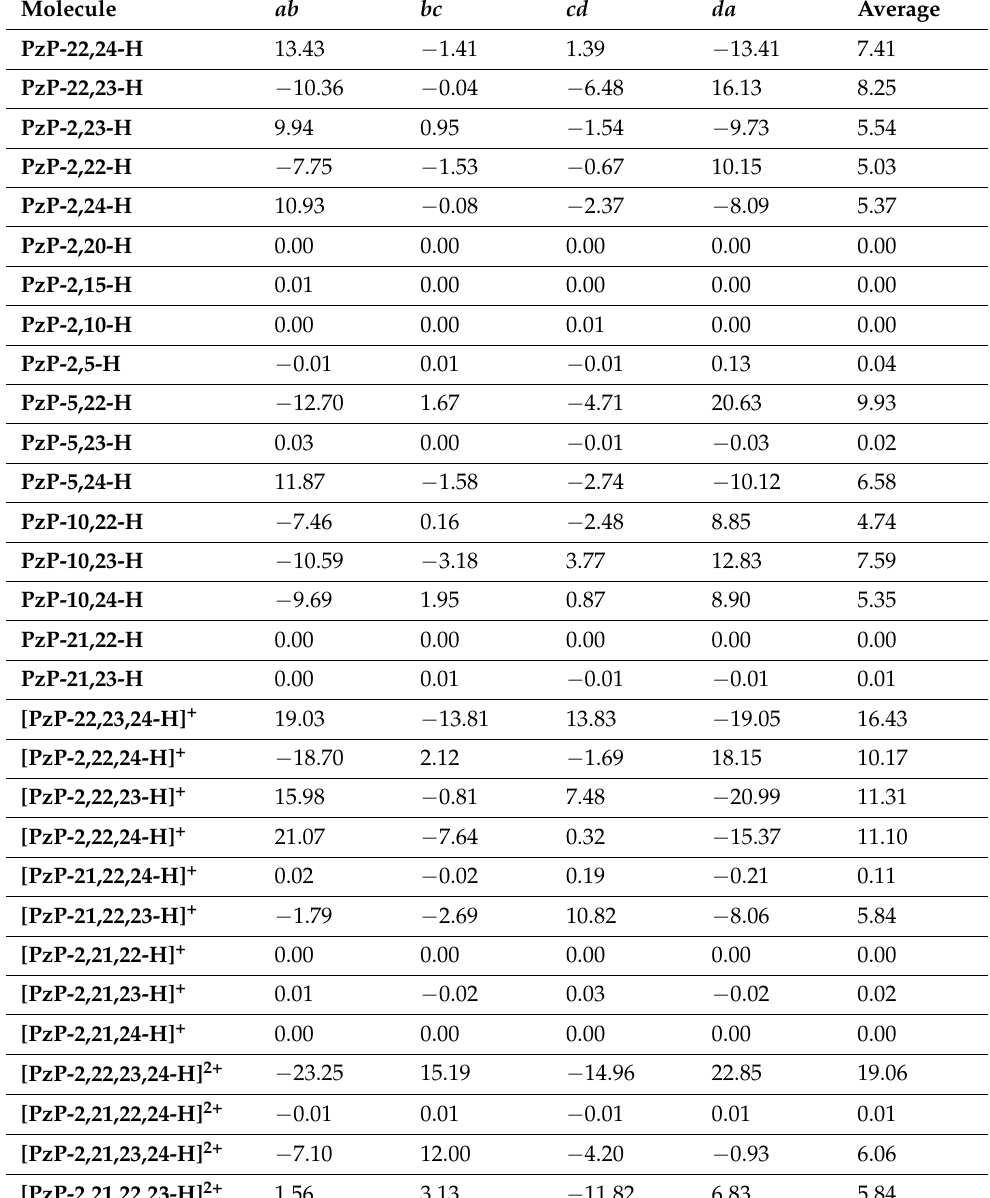
Table 3. Calculated dihedral angles for the individual pyrrole and pyrazole rings within a series of pyrazoloporphyrin tautomers and related protonated